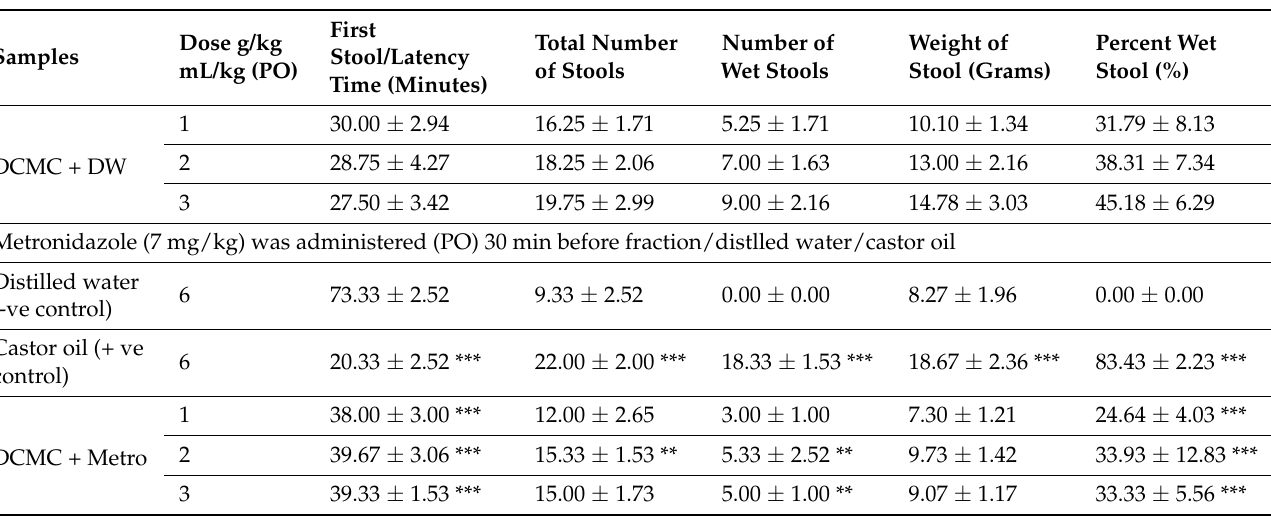
Table 6. Diarrheal/laxative activity of